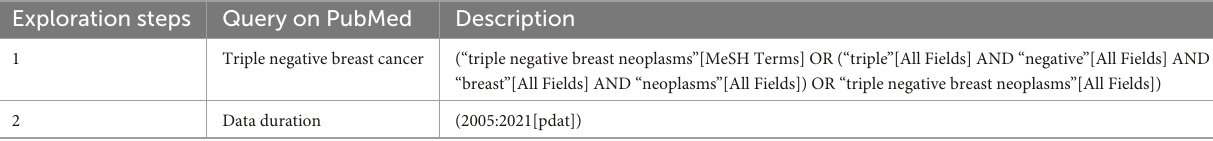
TABLE 2 Inclusive and exclusive criteria.